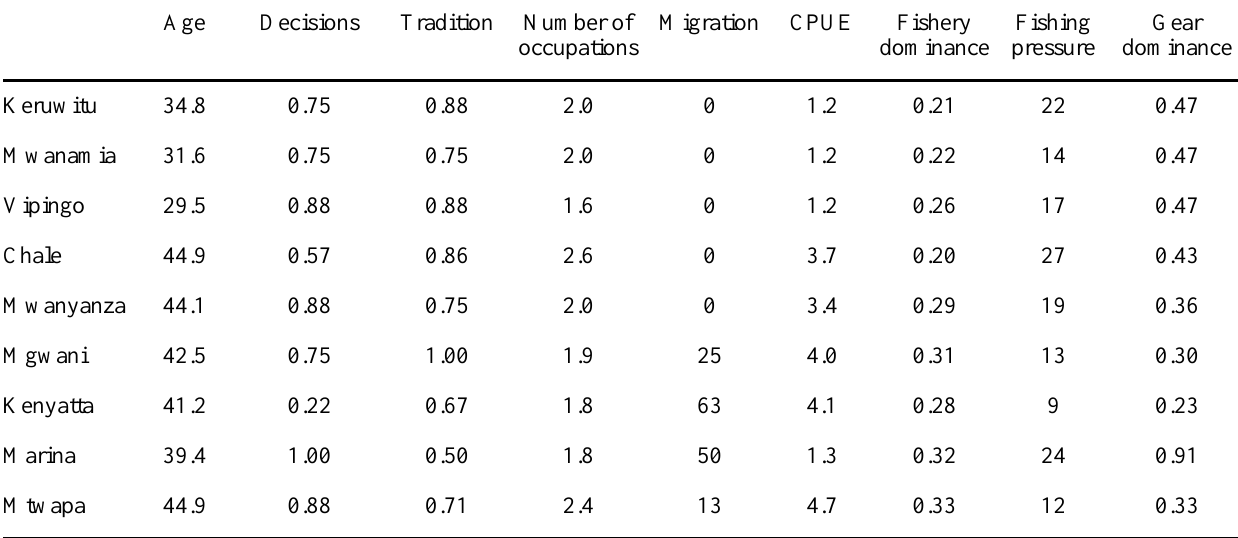
Table 2. Mean values for site-level socioeconomic characteristics. Age (years), involvement in decisions (ratio), tradition (ratio), migration (% having migrated into the region), CPUE (kg fisher -1 day -1 ), fishery dominance (Simpson’s index), fishing pressure (fisher km -2 ), gear dominance (Simpson’s index). Age Decisions Tradition Number of Migration CPUE Fishery Fishing Gear occupations dominance pressure